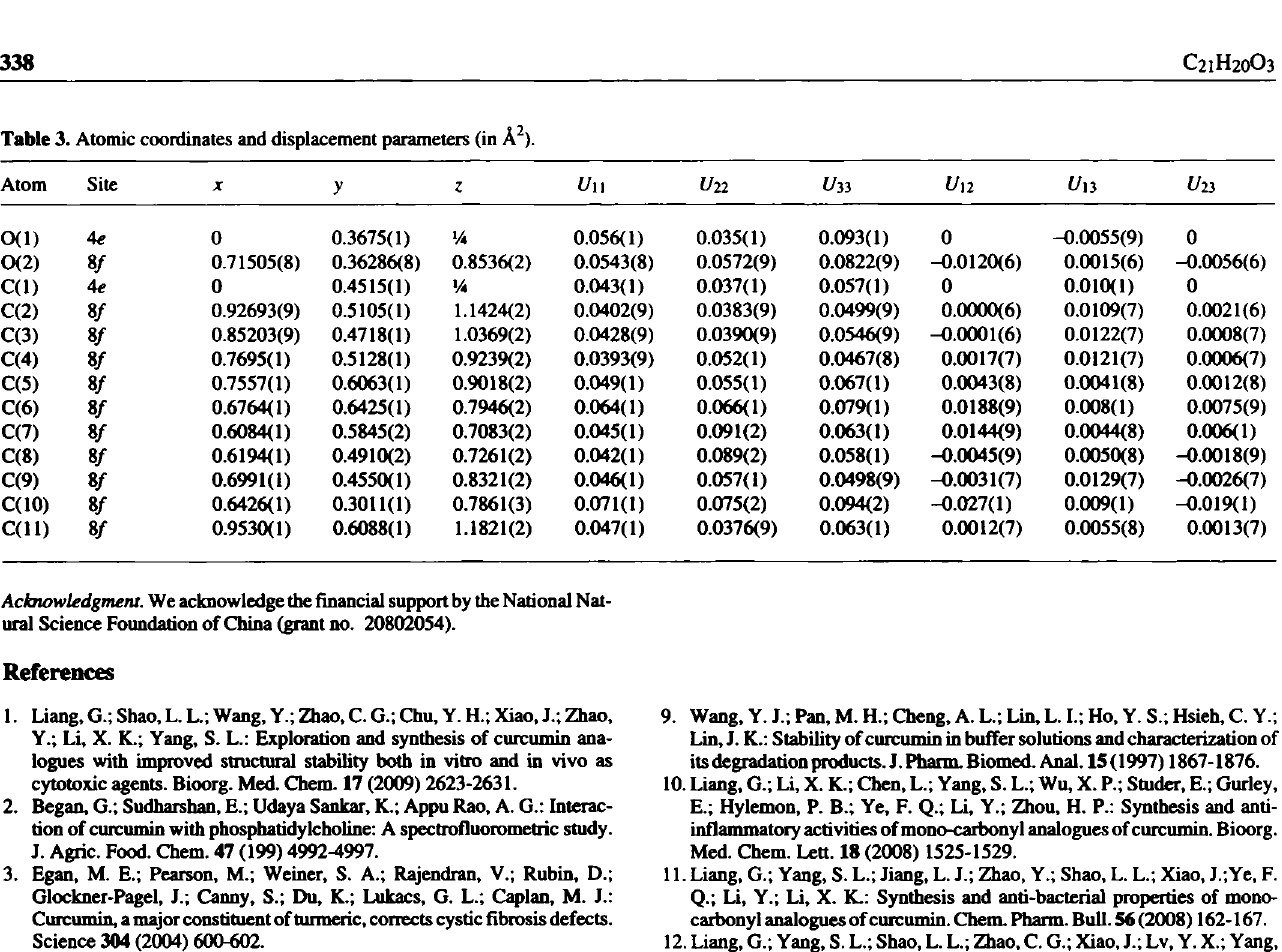
Table 3. Atomic coordinates and displacement parameters (in Â 2